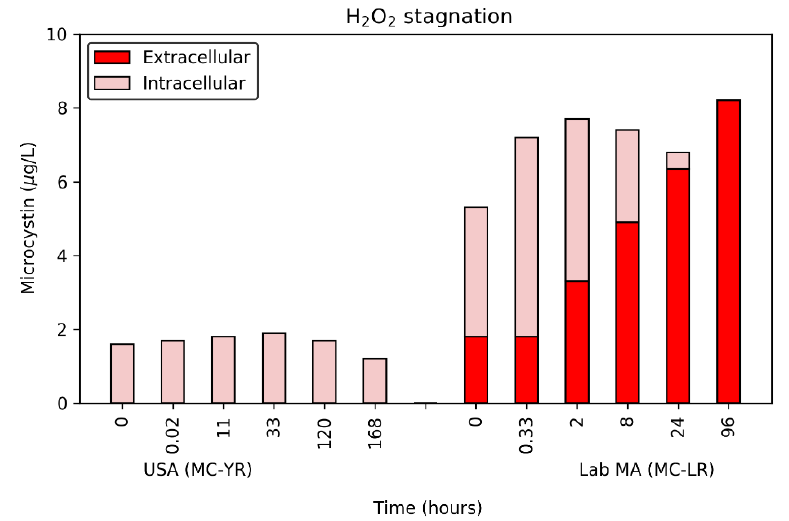
Figure 2. Impact of stagnation on the release of microcystins (MCs) from two cyanobacterial suspensions after exposure to 0.4 H 2 O 2 :DOC for 24 h (lab-cultured MA) or 20 min (USA bloom). Note: the CA bloom MC levels were not monitored during